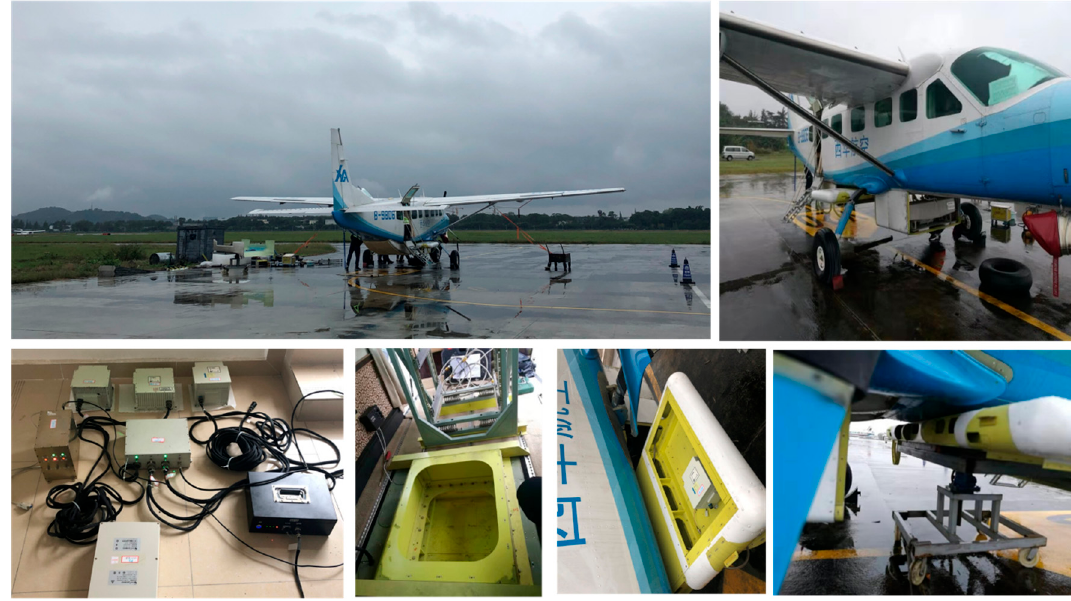
Figure 6. Installation layout.